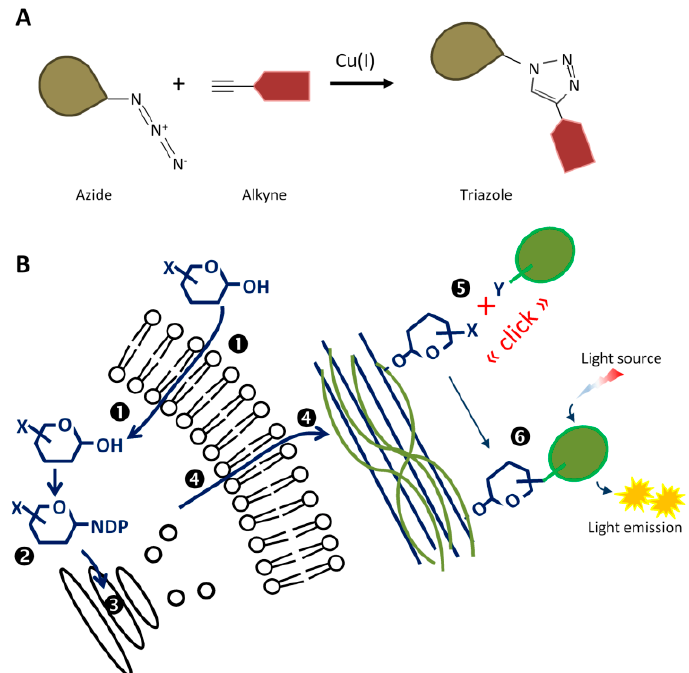
Figure 10. Principle of bioorthogonal reaction. ( A ) Bioorthogonal reaction of the azide–alkyne cycloaddition, also termed as a “click reaction”, in the presence of cuprous Cu(I) ions. ( B ) Schematic representation of the incorporation of a clickable sugar (X-sugar) (cid:202) , its activation as a nucleotide sugar (NDP sugar) (cid:203) , metabolic modification (cid:204) , excretion (cid:205) , labeling after click reaction with a compatible fluorophore (Y-fluorophore) (cid:206) and its visualization under light excitation (cid:207) . NDP: nucleotide diphosphate (mostly UridineDP or GuanineDP). X-sugar-NDP is an “activated glycosyl donor” which is the substrate of glycosyltransferases.